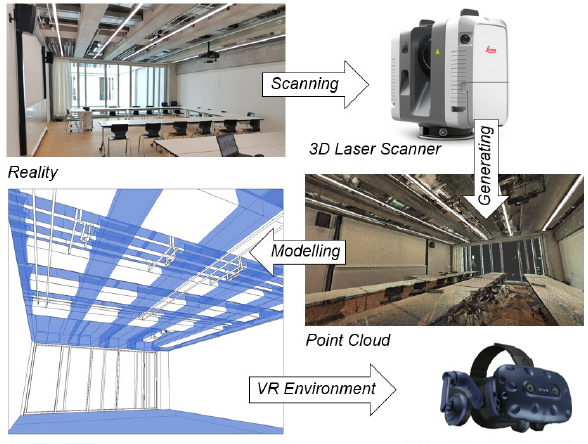
Figure 8. Digitising using laser scanning, BIM modelling and